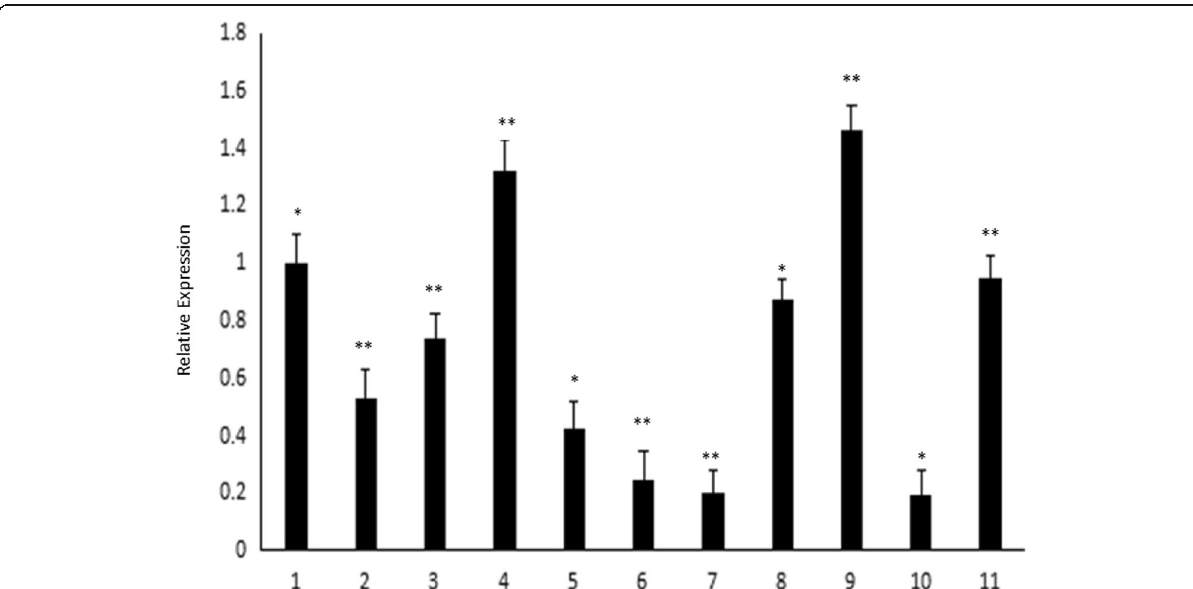
Fig. 3 Time and space expression pattern of Os6. In order to further understand the expression pattern of Os6 , RNA was extracted from different tissues and organs of the wild-type rice plants, then Reverse transcription into cDNA, detection of Os6 expression pattern by Real-Time PCR. 1: Seedling Root; 2: Seedling Stem; 3: Seedling Leaves; 4: Seedling Sheath; 5: Mature Root; 6: Mature Stem; 7: Mature Leaves; 8: Mature Flower; 9: Mature Endosperm; 10: dried seeds; 11: wet seeds